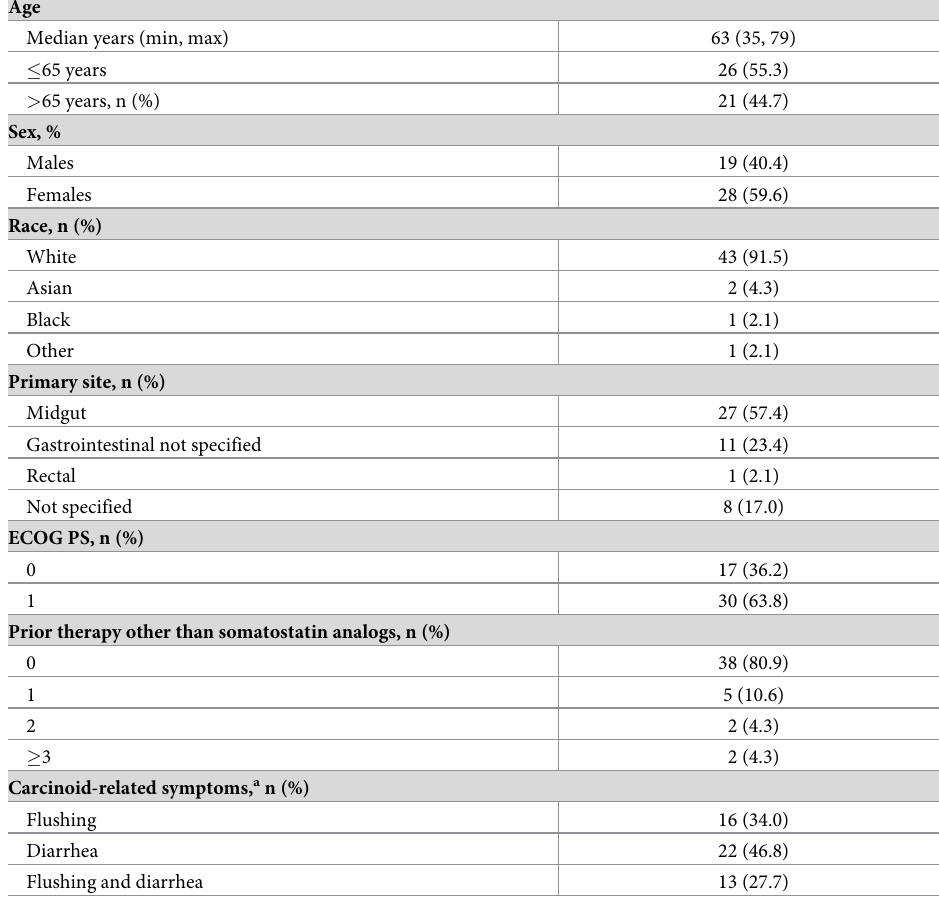
Table 1. Patient demographics and baseline characteristics (n =